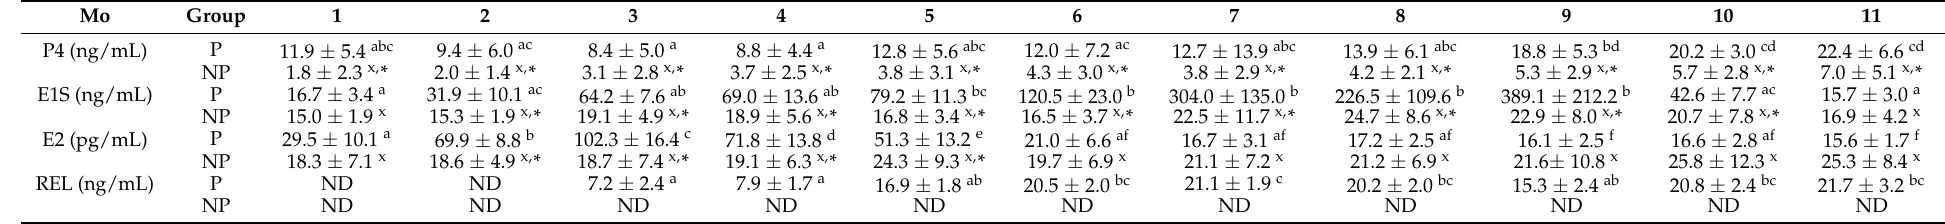
Table 2. Concentrations of selected reproductive hormones: progesterone (ng/mL), estrone sulfate (ng/mL), 17-ß estradiol (pg/mL), and relaxin (pg/mL) in serum of pregnant (P; n = 26) and non-pregnant (NP; n = 14) mares in consecutive months of pregnancy.